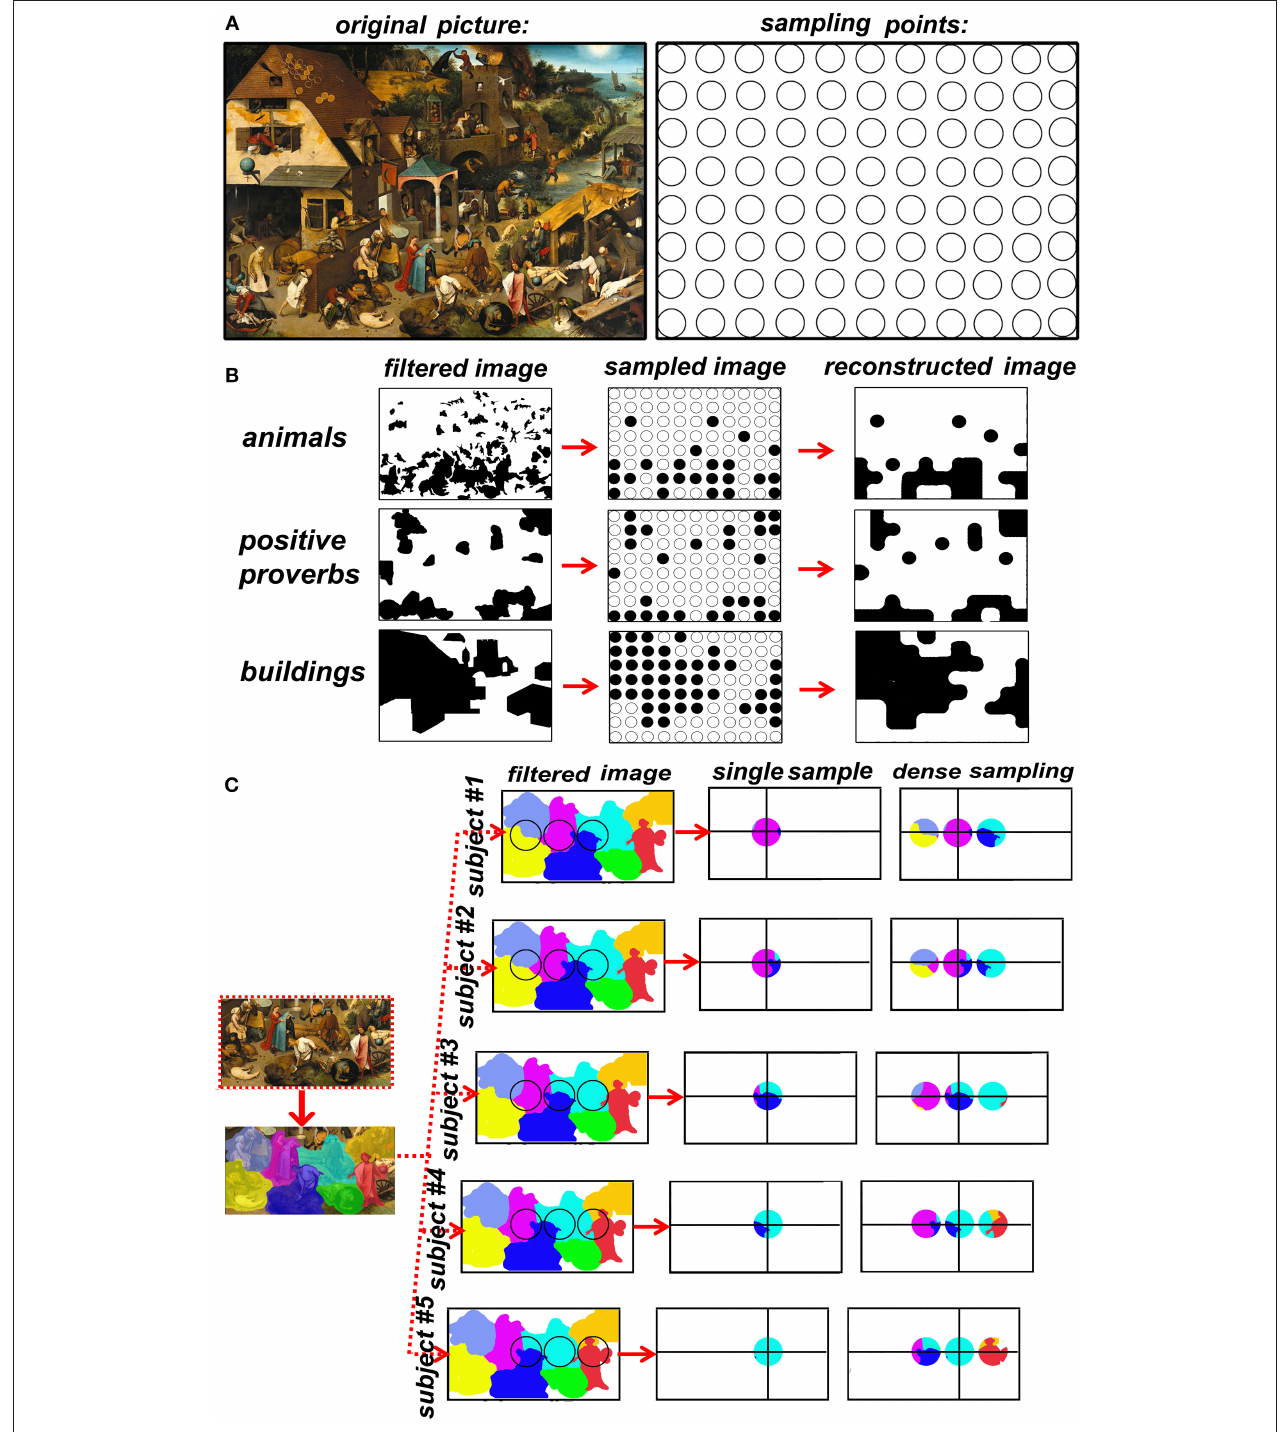
FIGURE 1 | (A) Left: Pieter Bruegel the elder’s “Netherlandish proverbs” (1559) 1 and the sampling grid. The image is a faithful photographic reproduction of a two-dimensional, public domain, work of art. (B) the effects of the choice of a feature of interest on spatial frequency of the raw signal. (C) the advantage of dense sampling in coping with inter-individual